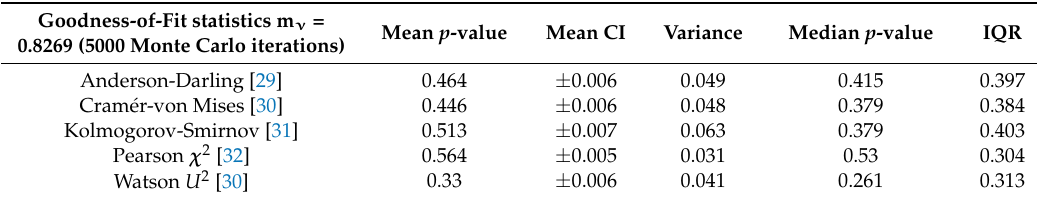
Table 5. Goodness-of-fit statistics from 5000 Monte Carlo iterations for the five common tests provided by Mathematica ® . CI is Confidence Interval; IQR is Interquartile Range.